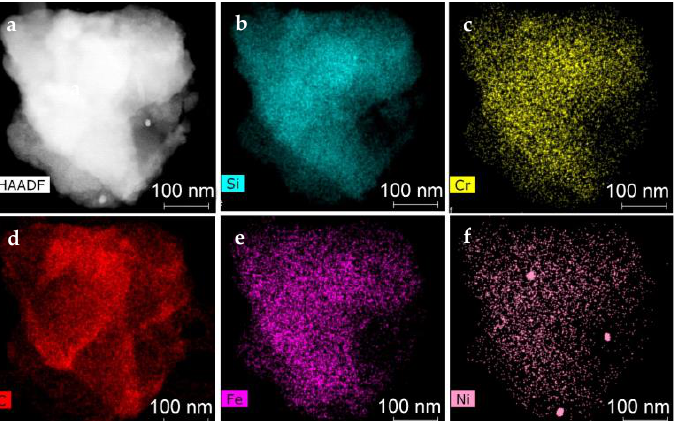
Figure 2. STEM dark field image ( a ) and EDS maps of Si ( b ), Cr ( c ), C ( d ), Fe ( e ) and Ni ( f ) of SiO 2 - Fe 3 O 4 -PPP-Cr-Ni nanocomposite.